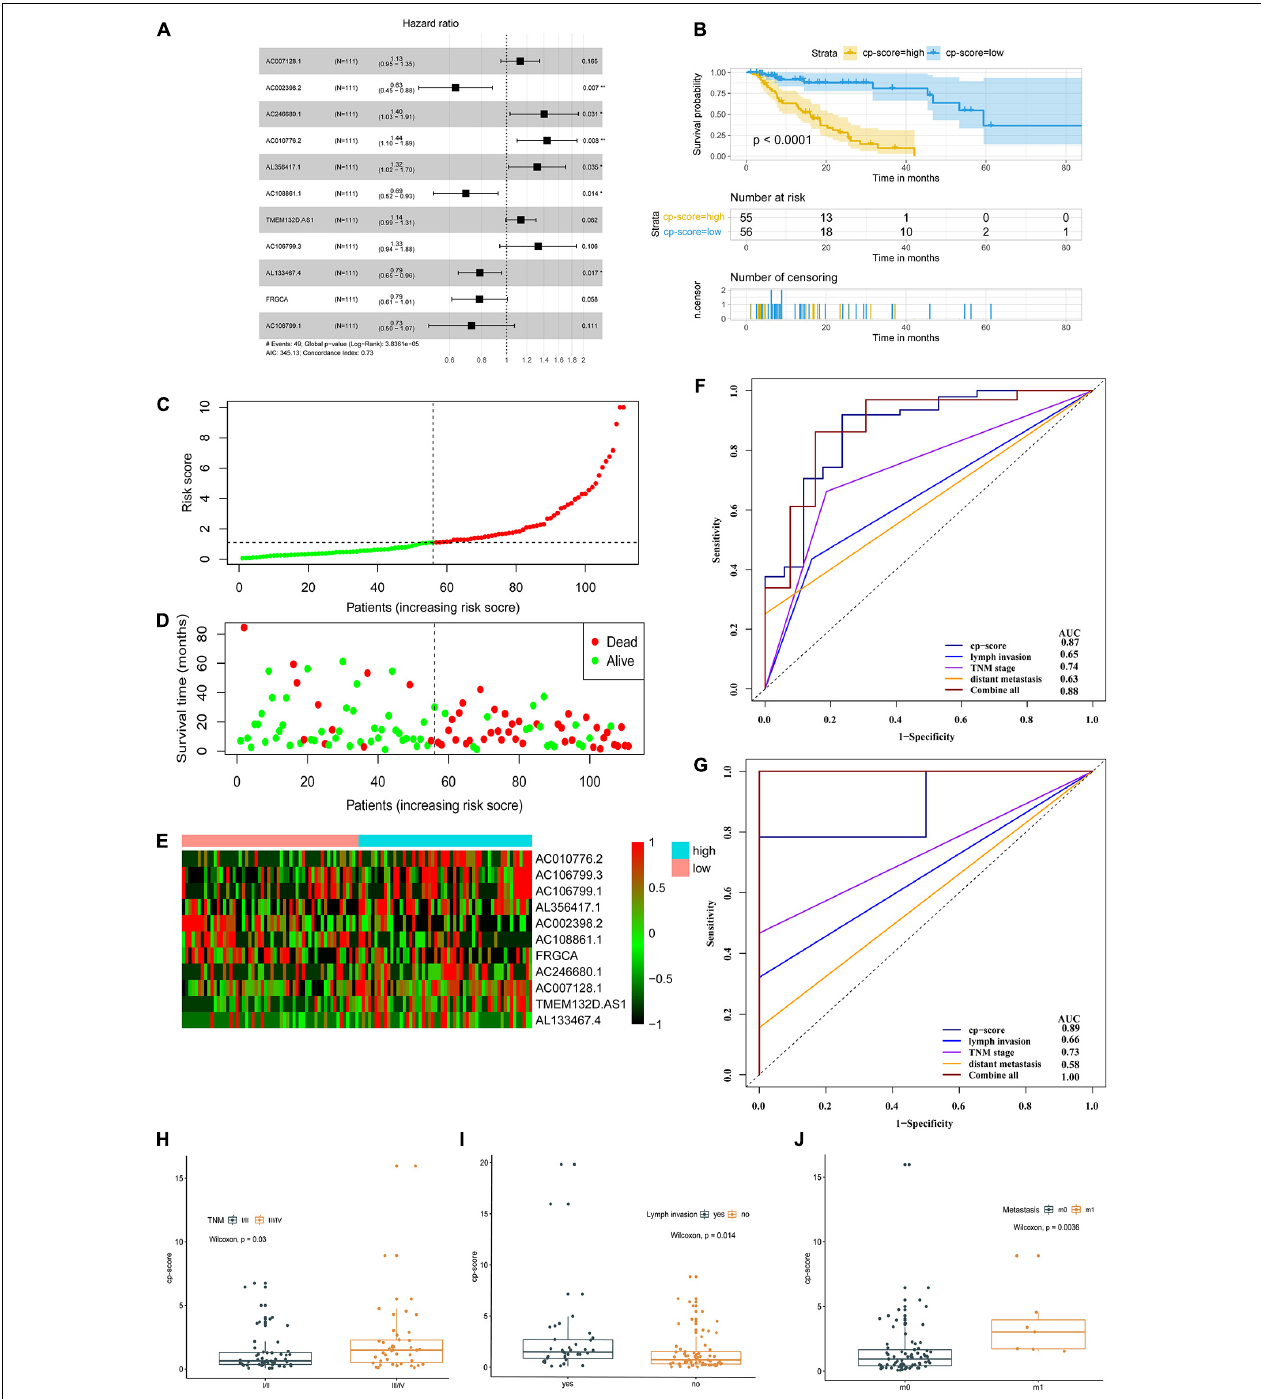
FIGURE 2 | A prognostic model of ESCC survival based on 11 differential and prognostic lncRNAs. (A) Forest plot illustrated the HR and 95% CI of the 11 lncRNAs by the multivariate Cox regression. HR, hazard ratio; CI, confidence interval. (B) OS curves of ESCC patients with the low and high risk groups according to the cp-score in TCGA cohort. (C–E) The distribution of 11-lncRNA risk score (C) , OS status (D) , and corresponding lncRNA expression profiles (E) . The intersection of horizontal and vertical dotted lines represents the risk score of the person ranked in the middle. (F) Time-dependent ROC and corresponding AUCs for 3-year survival predicted by cp-score, TNM stage, lymph node metastasis, distant metastasis, and the combination of all these factors. (G) ROC and corresponding AUCs for 5-year OS predicted by cp-score, TNM stage, lymph node metastasis, distant metastasis, and the combination of all these factors. (H) LncRNA analysis of cp-score of patients with stage I/II and stage III/IV disease. (I) cp-score in patients with and without lymph node metastasis. (J) cp-score in patients with and without distant metastasis.